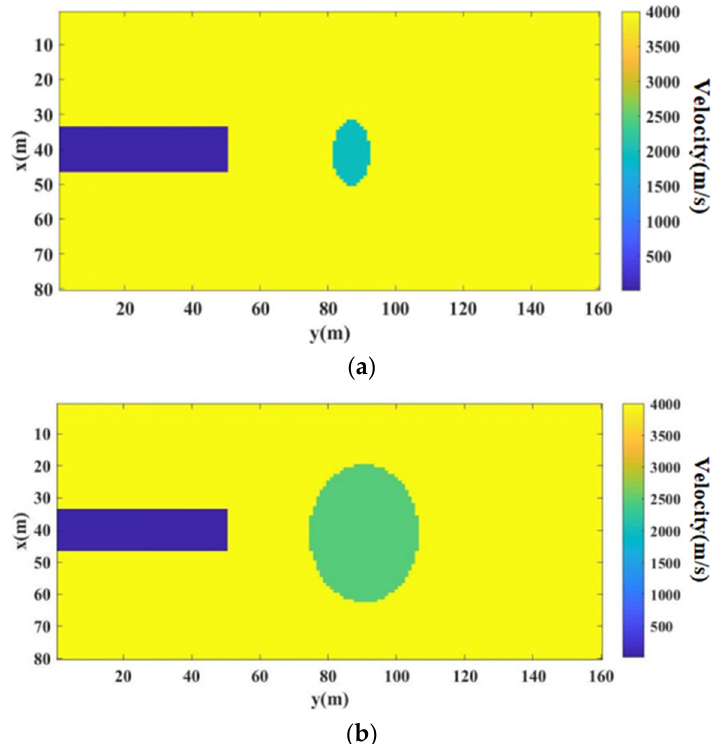
Figure 10. ( a ) A 10 m karst rock wave velocity numerical model. ( b ) A 30 m karst rock wave velocity numerical model.